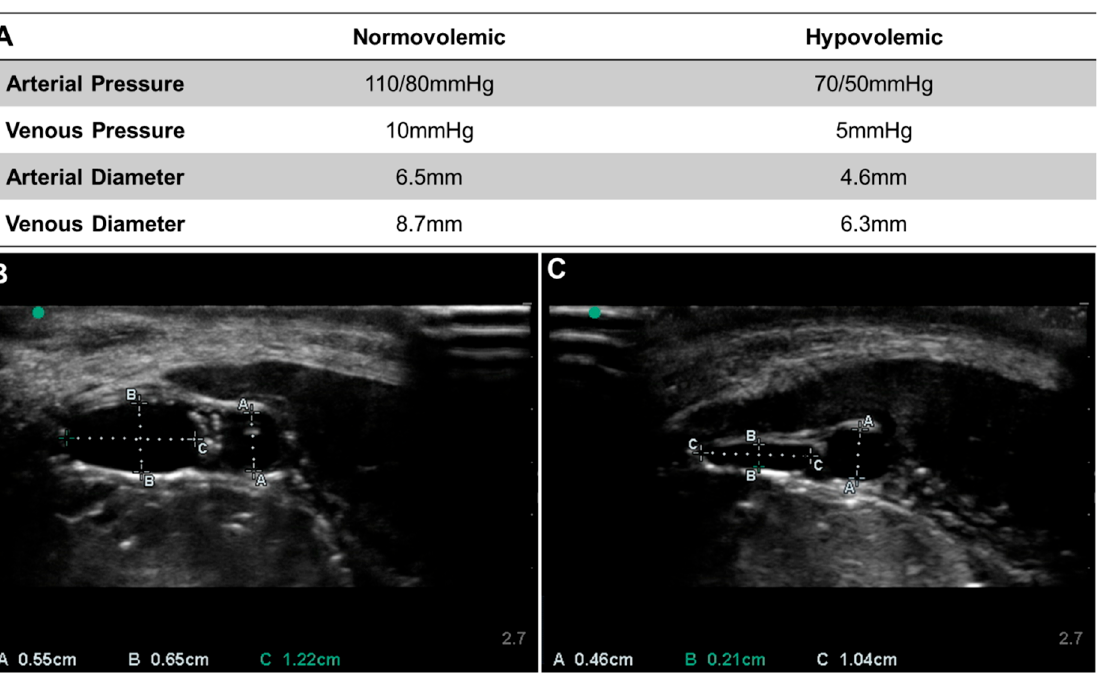
Figure 4. Dimensions for the Lower-body Ex Vivo Porcine Model. ( A ) Normovolemic and Hypovolemic measurements for pressure and diameters for the first ex vivo porcine specimen. ( B ) Normovolemic and ( C ) Hypovolemic ultrasound images and dimension overlays for an additional ex vivo model specimen.